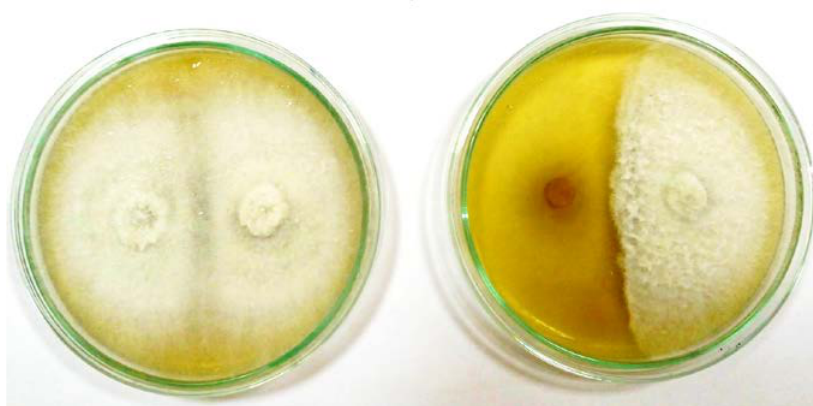
Fig. 1. Lack of the antagonistic effect between P. indica and Fo in vitro . Left PDA plate (control) inoculated with two discs of Fo; The right plate was included with one disc of Pi (left) and one of Fo (right)